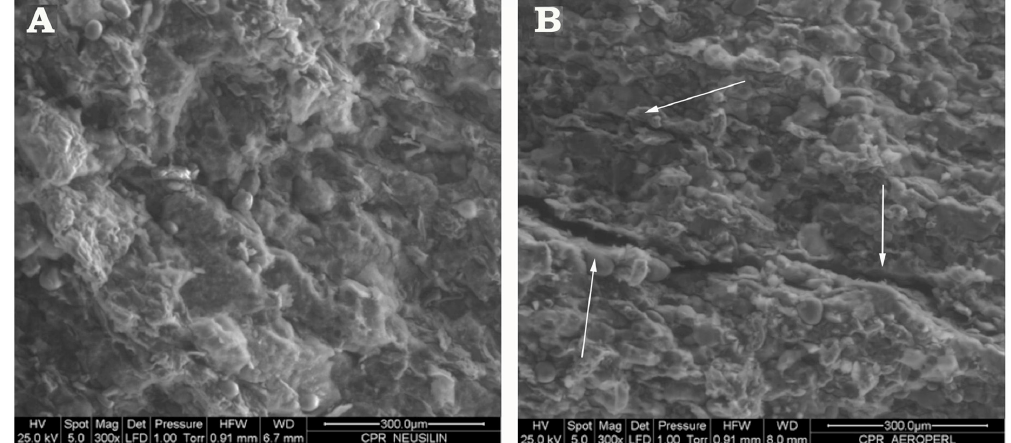
Figure 8. ESEM images of the surface of glyburide liquisolid tablets LS1 ( A ) and LS2 ( B